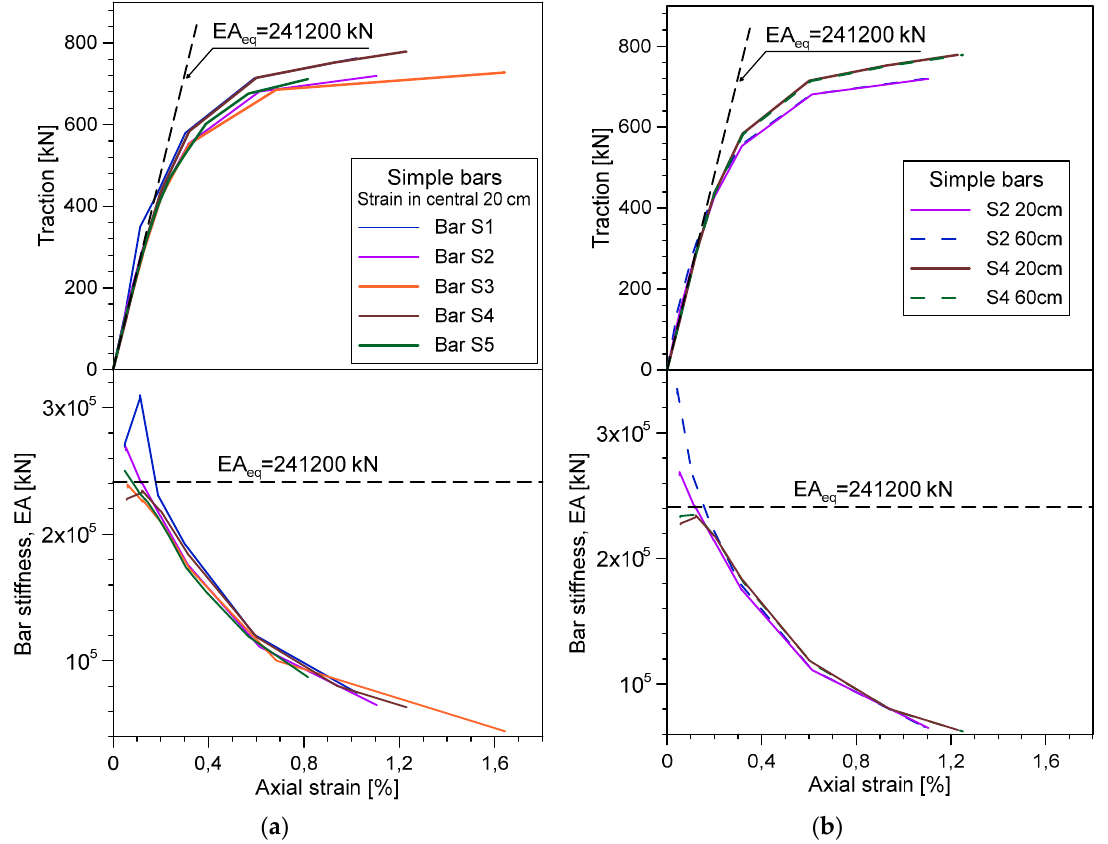
Figure 7. Traction vs strain and bar sti ff ness vs strain on simple bars tested in the laboratory: ( a ) mean strain recorded by the DFOS in the central 20 cm; ( b ) mean strain recorded by the DFOS in the central 20 cm vs. entire portion BC.